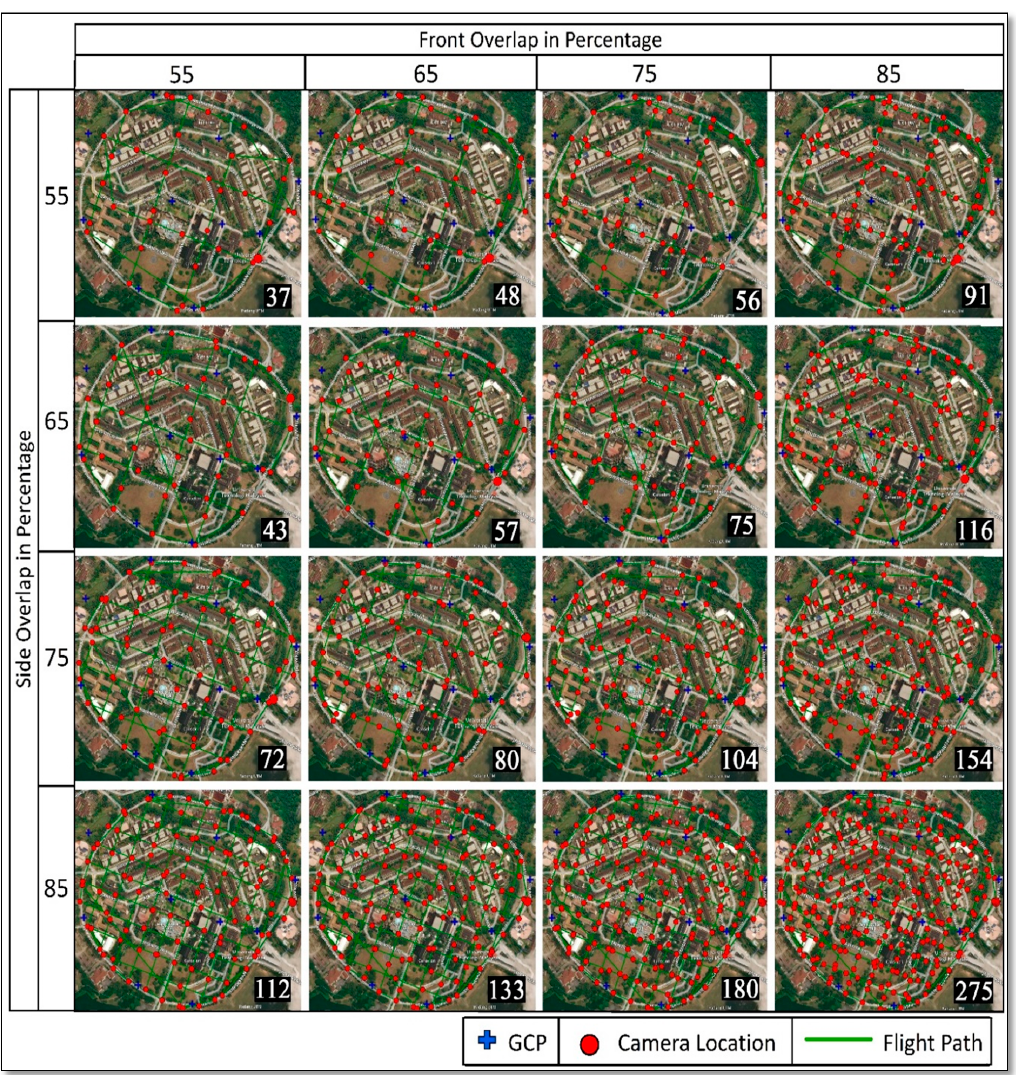
Figure 3. Flight plan and number of images.